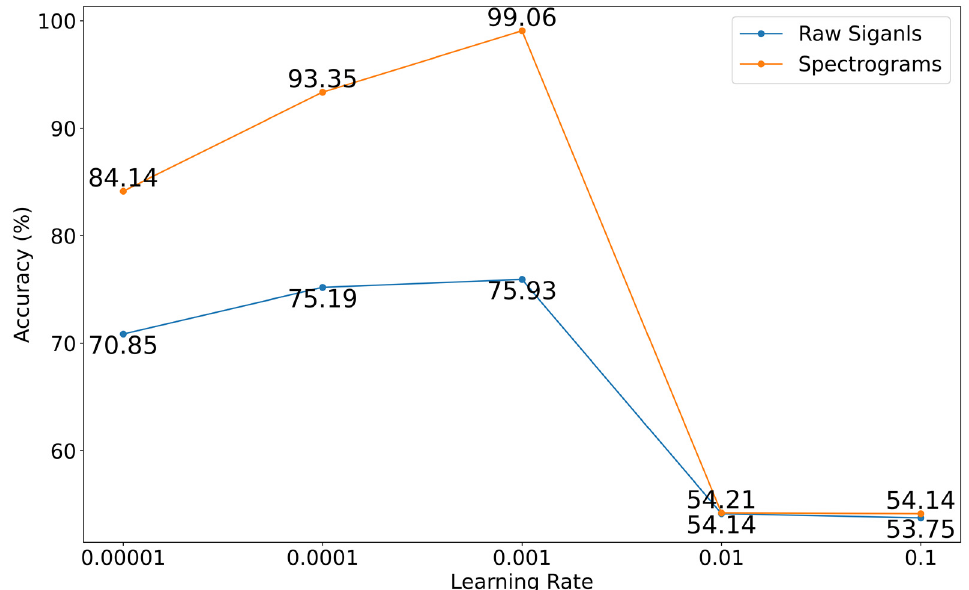
Figure 7. Learning rate evaluation on both datasets: raw signals and spectrograms: x -axis (learning rate), y -axis (accuracy).